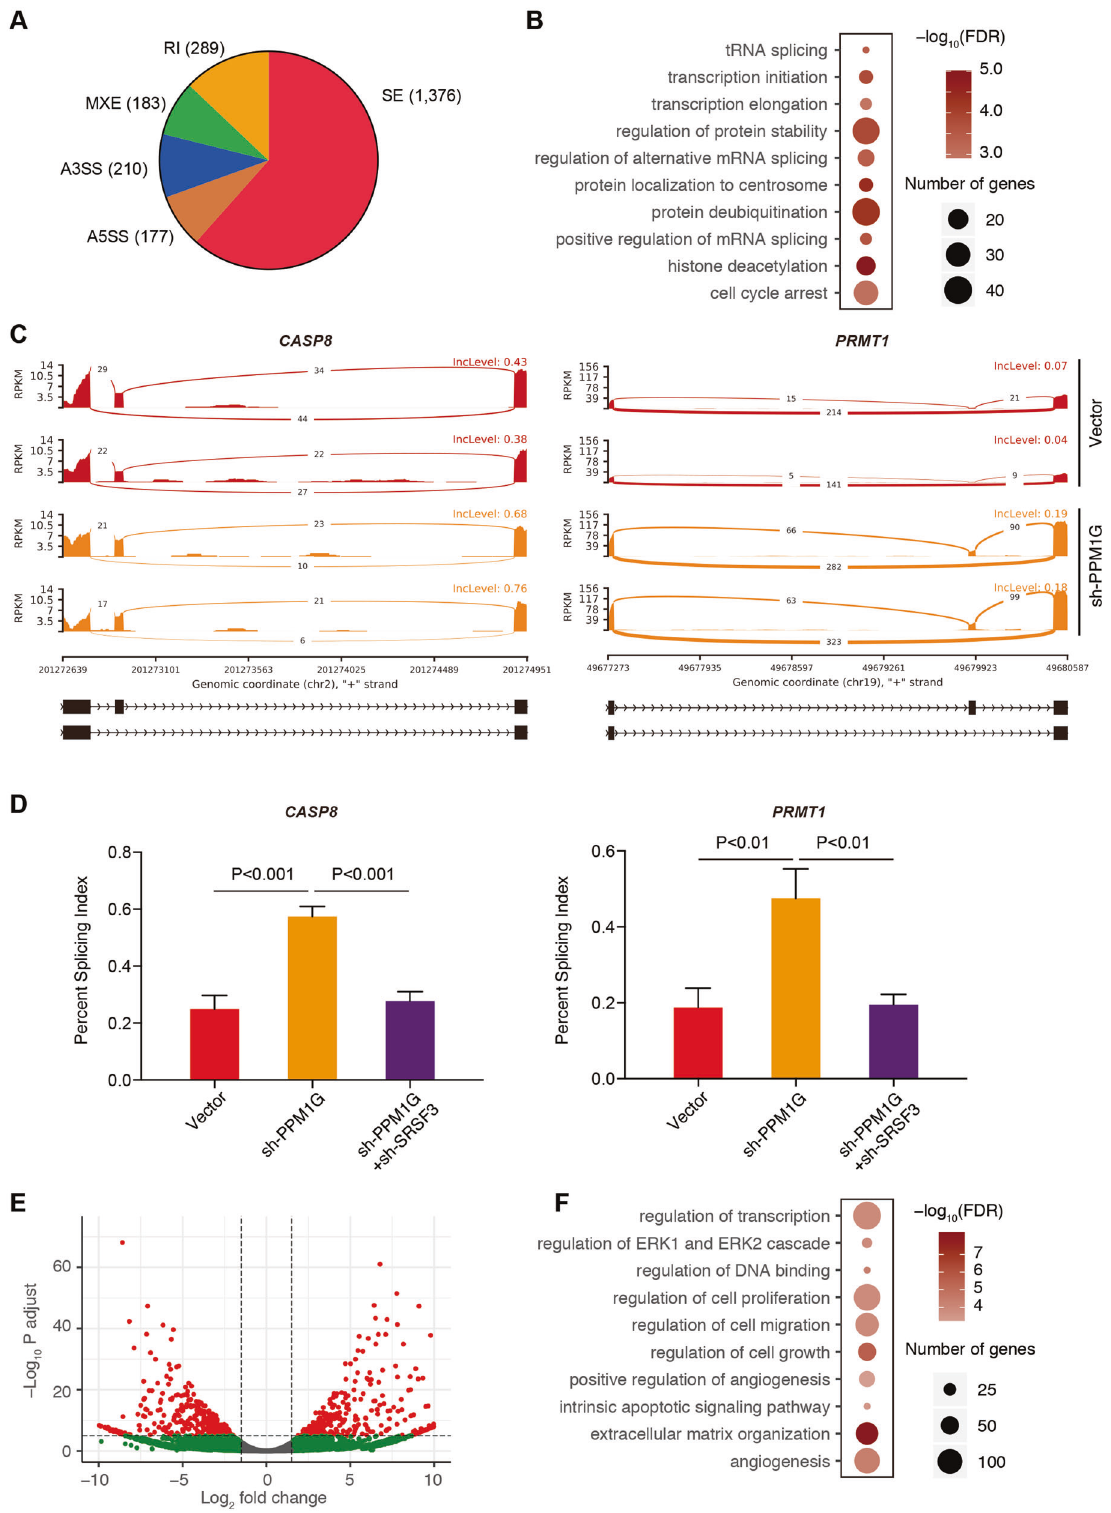
cycle arrest and transcriptional regulation, affecting gene expres- sion related to cell proliferation, cell migration, and angiogenesis. Mechanistically, the PPM1G-mediated alternative splicing regula- tion was achieved by its regulation on the phosphorylation of